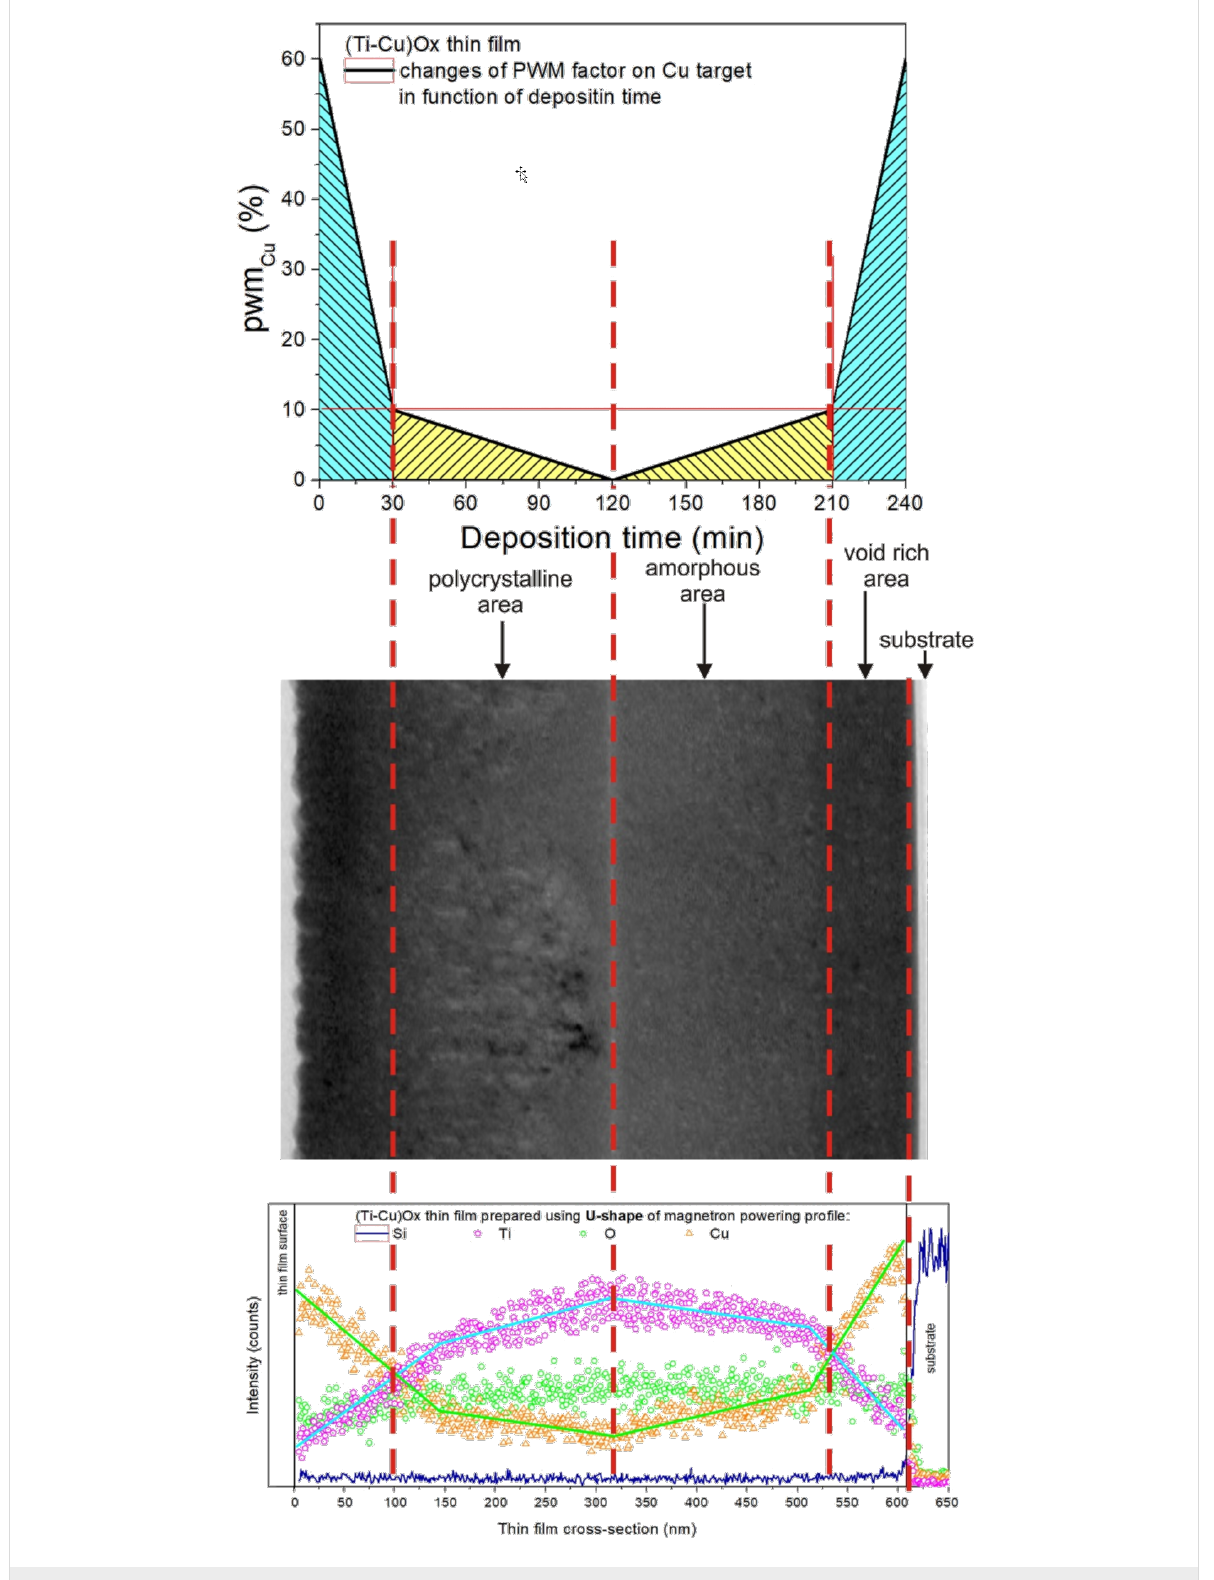
Figure 8: Results of TEM analysis and distribution of Cu, Ti, O, and Si in the gradient (Ti–Cu)Ox thin film with correlation to U-shaped-like changes of the pwm